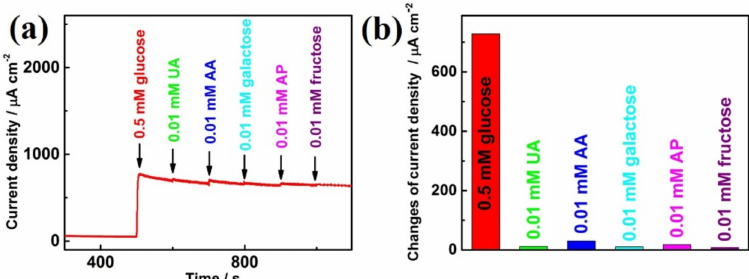
Figure 7. ( a ) Interference test of Ni 0.7 Co 0.3 (OH) 2 / CP with 0.5 mM glucose, 0.01 mM uric acid (UA), 0.01 mM ascorbic acid (AA), 0.01 mM galactose, 0.01 mM acetaminophen (AP), 0.01 mM fructose, and 0.5 mM glucose successively at + 0.6 V in 0.1 M NaOH. ( b ) A plot that shows the changes in current density caused by the addition of glucose and other